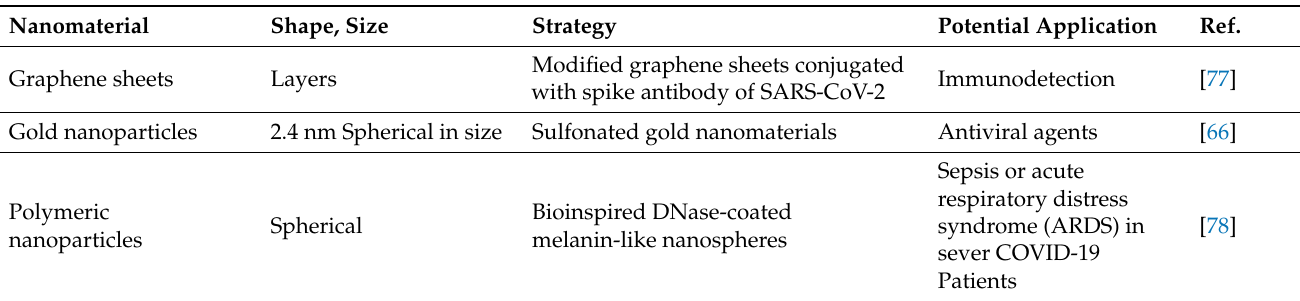
Table 6. Nanomaterials based approach to manage